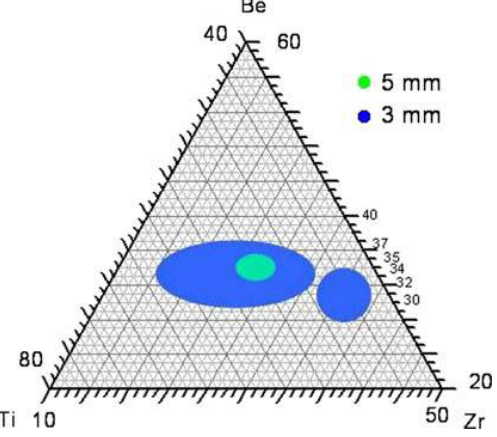
Figure 6. Glass-formation zones of 3 mm and 5 mm rods in the Ti–Zr–Be ternary alloy system. Reproduced with permission from [43]. Copyright 2010, Springer.